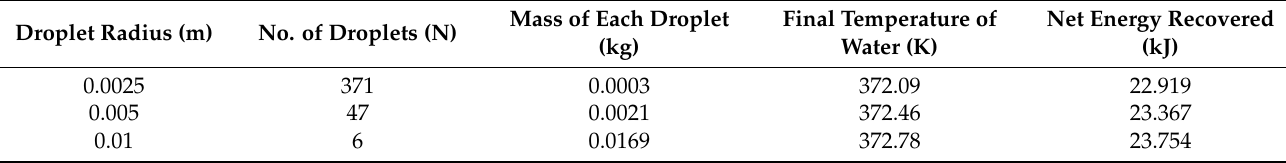
Figure 10. Temperature increase in water by CuCl droplets for the quenching height of 20 cm. Table 3. Properties of droplets for the quenching height at 20 cm for 1 kg of H 2